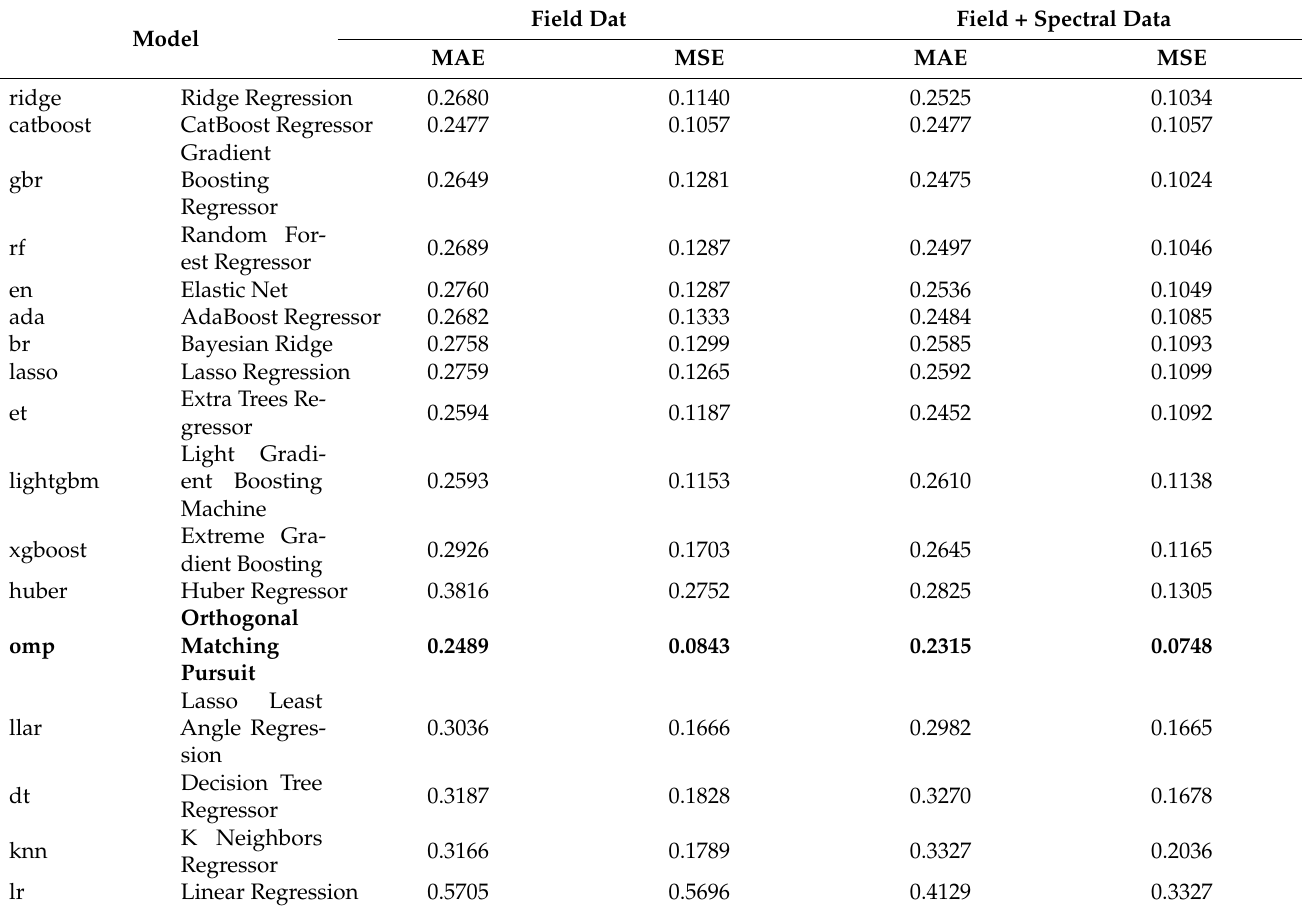
Table 3. Yield prediction results including MAE and MSE